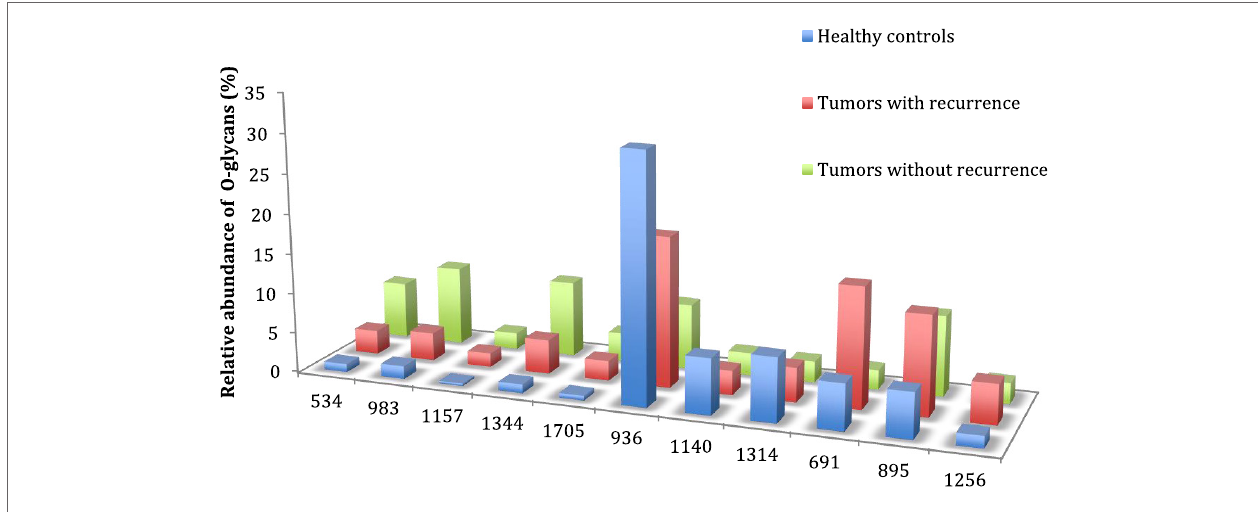
FigUre 5 | comparison of the relative abundance of major mucin O-glycans between healthy controls ( n = 5), tumors with recurrence ( n = 3), and tumors without recurrence ( n = 6) . The mean is represented for all measurements. A decrease in the level of expression of core 3-based glycans from healthy controls to tumors without recurrence is seen with the ions at m/z 936, 1,140, and 1,314 and an increase in the core 1-based glycans is represented by the ions at m/z 534, 983, 1,157, and 1,344. Tumors with recurrence expressed higher levels of sialyl Tn (ion at m/z 691), sialyl T (ion at m/z 895), and disialyl T antigens (ion at m/z 1,256), compared to healthy controls and tumors without